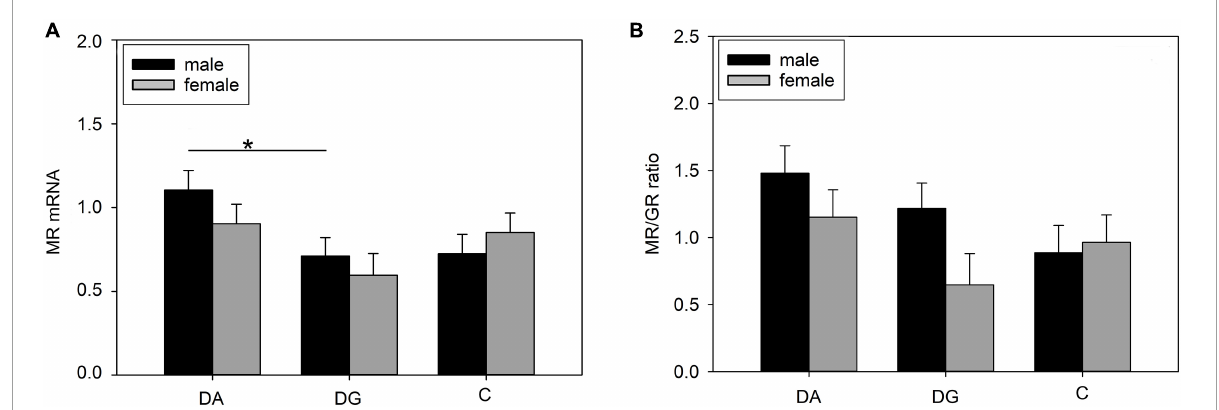
FIGURE7 Gene expression in the hippocampus of piglets on PND 20. (A) MR (mineralocorticoid receptor; NR3C2) mRNA expression and (B) MR/GR ratio of DA (deprivation alone), DG (deprivation with a group of littermates), and C (control, no deprivation) piglets. Data are expressed as arbitrary units after normalization to ACTB and TBP mRNA expression as endogenous reference genes and represent the LS means ± SE. Significant differences are indicated by asterisks (* p < 0.05; Tukey-Kramer test; n = 10 per treatment group and